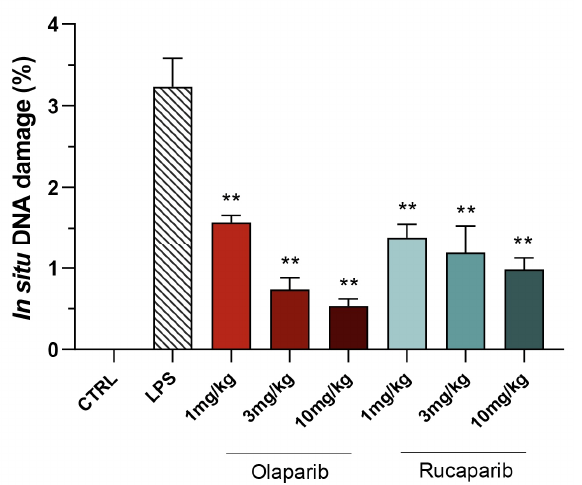
Figure 14. Effect of olaparib and rucaparib on DNA damage in the lung in a murine model of ALI. C57Bl/6 mice received either PBS (30 µL) or LPS (50 µg in 30 µL PBS) by intratracheal instillation in the absence or presence of various doses (1, 3, or 10 mg/kg) of olaparib or rucaparib. After 24 h, DNA damage in the lung was quantified by the TUNEL assay. Top panels show representative histological images. ** p < 0.01 indicates the beneficial effect of the PARP inhibitors tested. Data are shown as mean ± SEM, n = 8–12/group. Both PARP inhibitors reduced TNF-α, IL-1β and MIP-1α levels in the bronchoalveolar lavage fluid, while IL-6 levels were largely unaffected; overall, the efficacy of olaparib was higher than that of rucaparib (Figure 15).